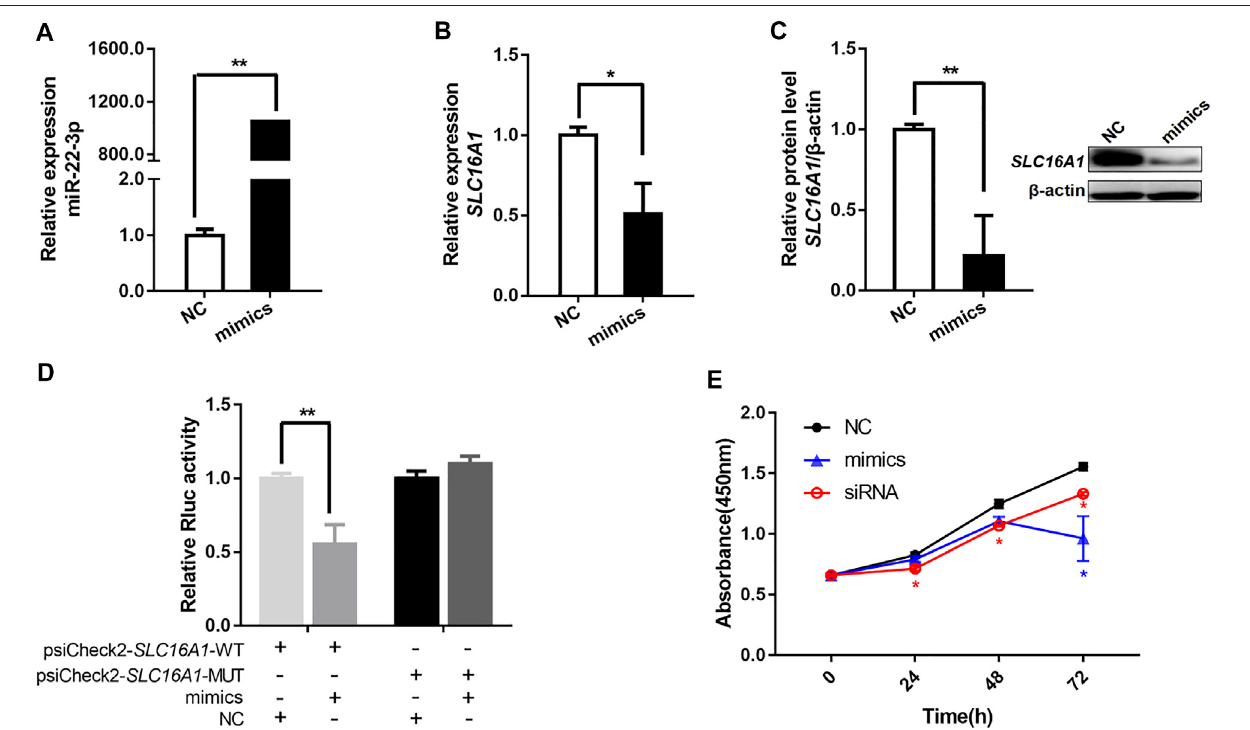
FIGURE 6 | miR-22-3p inhibits bovine hepatocytes activity by targeting the 3 ’ UTR of SLC16A1 . In bovine hepatocytes transfected with miR-22-3p mimic, (A) relative expression of miR-22-3p, and (B) relative expression of SLC16A1 mRNA and (C) protein. (D) Inhibitory effect of miR-22-3p on SLC16A1 3 ’ UTR, determined usingadual-luciferaseassaytocomparemiR-22-3ptargetsitesinthe SLC16A1 mRNA3 ’ UTRvsamutantvariant. (E) BovinehepatocytesactivitydeterminedbyCCK- 8 assay after transfection with miR-22-3p mimic or SLC16A1